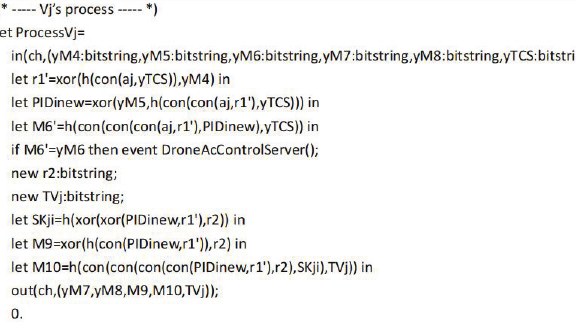
Figure 8. The process of V j .